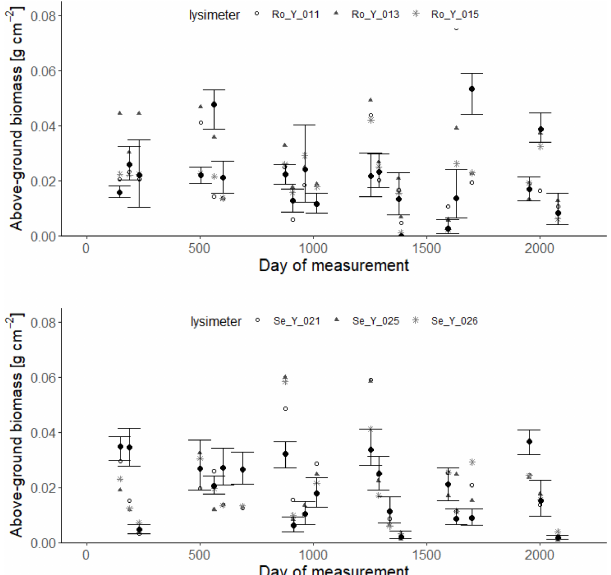
Figure 9. Measured daily leaf area index (symbols; 2013–2018) compared with simulations for the 30 acceptable parameterizations at each site (black lines). Day 1 is 1 January 2013.